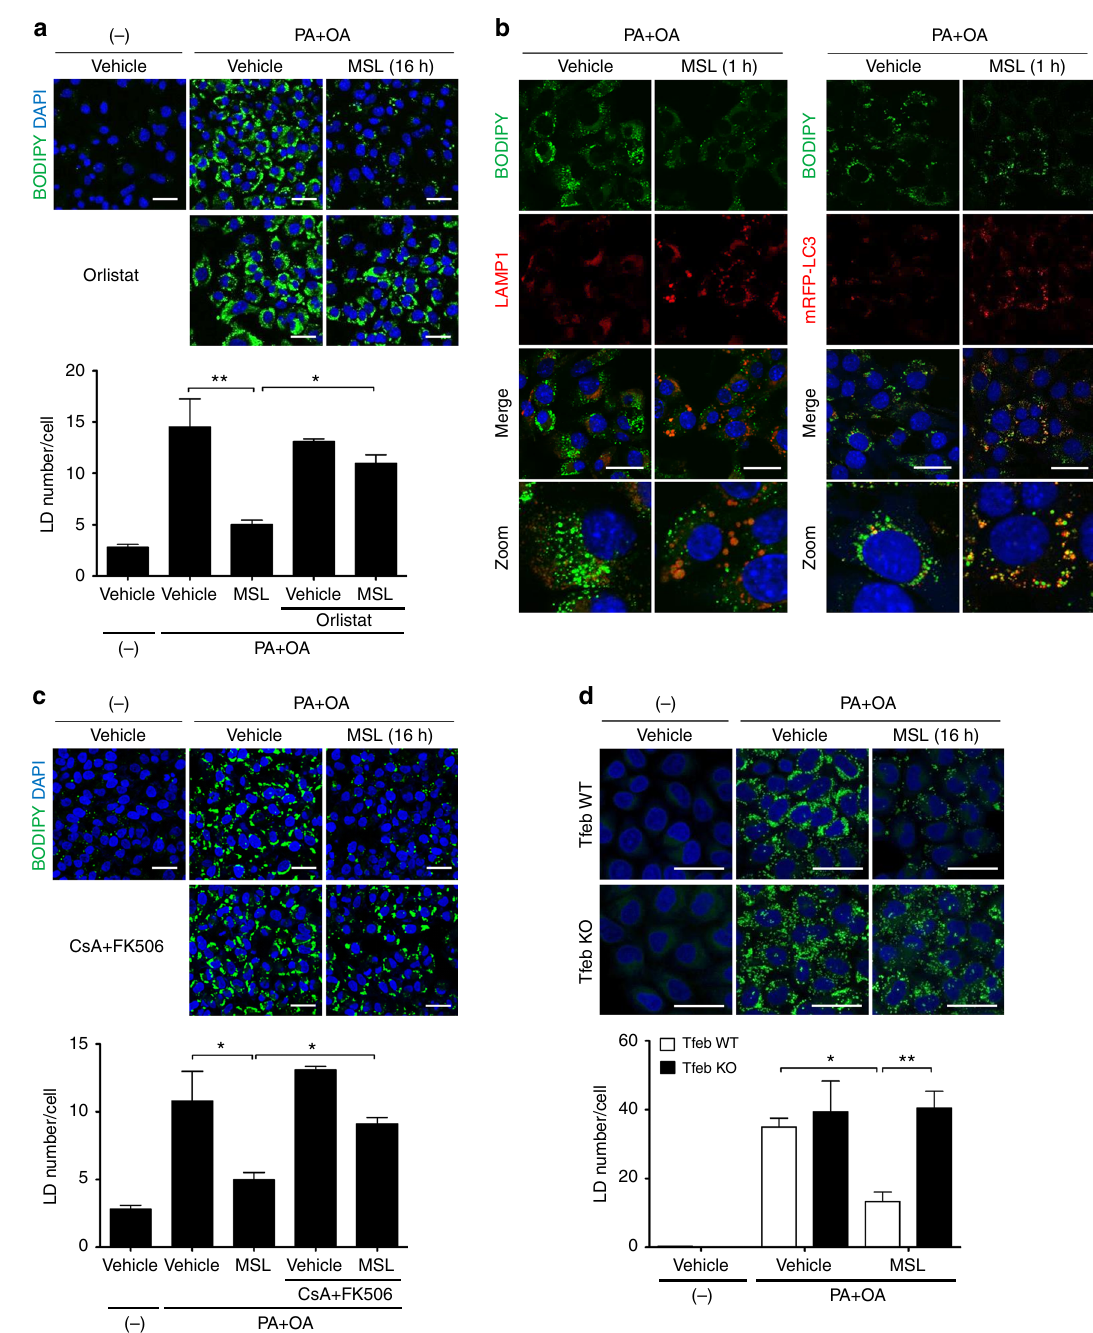
Fig. 3 Decreased intracellular lipid after treatment with autophagy enhancer. a HeLa cells incubated in 2% fatty acid-free BSA-DMEM containing PA (400 μ M) and OA (800 μ M) for 24h were treated with MSL in the presence or absence of orlistat. Control cells indicated as (-) were incubated in solvent alone (2% fatty acid-free BSA-DMEM). After staining with BODIPY493/503, cells were subjected to confocal microscopy to determine the number of lipid droplets (LDs) ( F = 14.3, df treatment = 4, df residual = 8). b HeLa cells loaded with PA + OA combination as in a were treated with MSL. After immunostaining with anti-LAMP1 antibody and BODIPY493/503 staining, confocal microscopy was conducted (left panel). mRFP-LC3 -transfected HeLa cells were loaded with PA + OA combination as in a and then treated with MSL. After staining with BODIPY493/503, confocal microscopy was conducted (right panel). c HeLa cells were treated and examined as in a after pretreatment with CsA + FK506 combination ( F = 15.9, df treatment = 4, df residual = 8). d WT or Tfeb knockout HeLa cells were treated and examined as in a ( F = 21.3, df treatment = 5, df residual = 10). All data in this fi gure are the means ± s.e.m. from ≥ 3 independent experiments performed in triplicate (scale bar, 20 μ m). * P < 0.05 and ** P < 0.01 by one-way ANOVA with Tukey ’ s